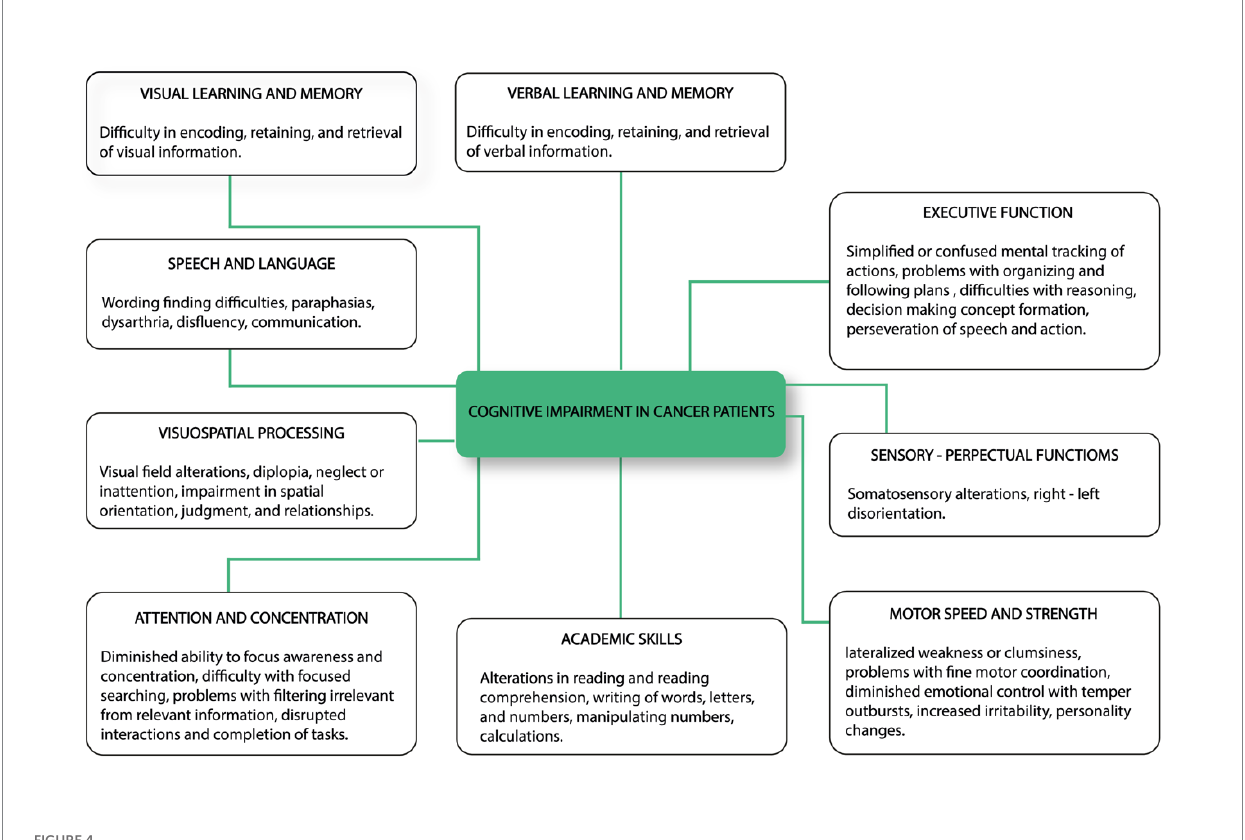
FIGURE 4 Common cognitive impairments identified in cancer patients including visual learning and memory, speech and language, visuospatial processing, attention and concentration, academic skills, motor speed and strength, sensory-perceptual functions and executive function (Pendergrass et al., 2018,